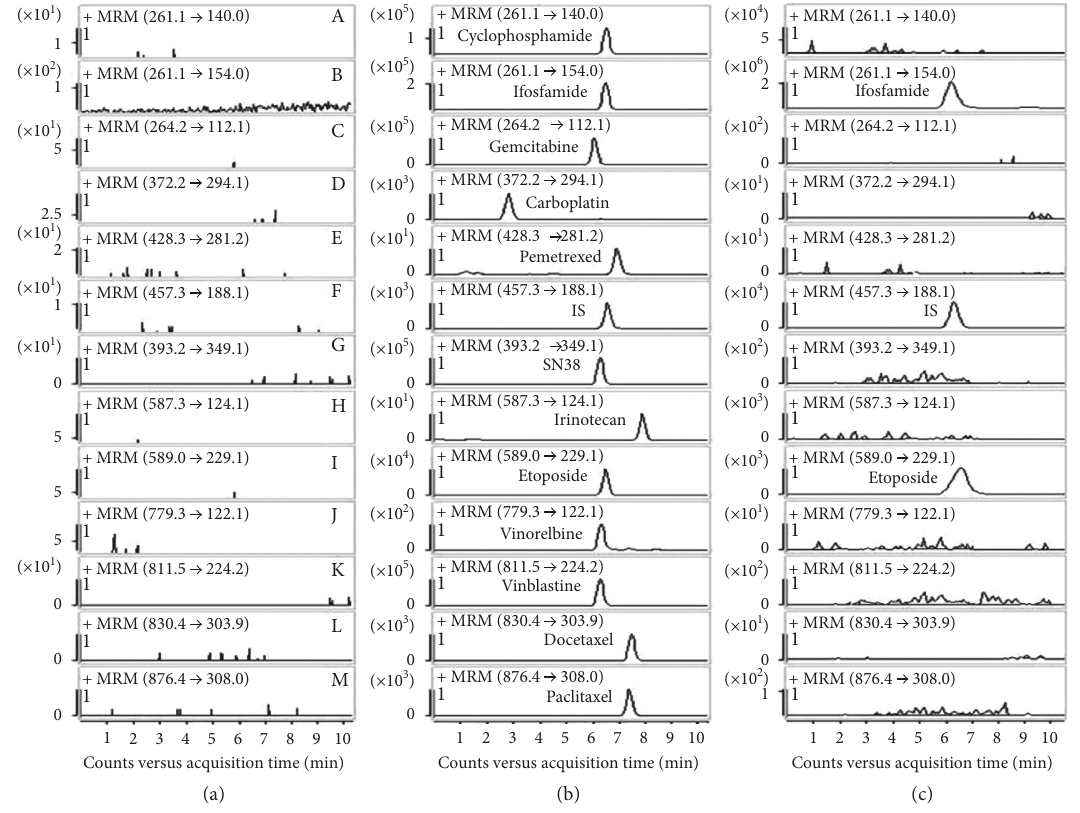
Figure 2: Representative MRM chromatograms of paclitaxel (A), docetaxel (B), vinblastine (C), vinorelbine (D), pemetrexed (E), car- boplatin (F), etoposide (G), cyclophosphamide (H), ifosfamide (I), gemcitabine (J), irinotecan (K), SN-38 (L), and vindoline (M, IS). (a) Blank plasma sample, (b) blank plasma sample spiked with twelve analytes at LLOQ and IS, and (c) plasma sample collected